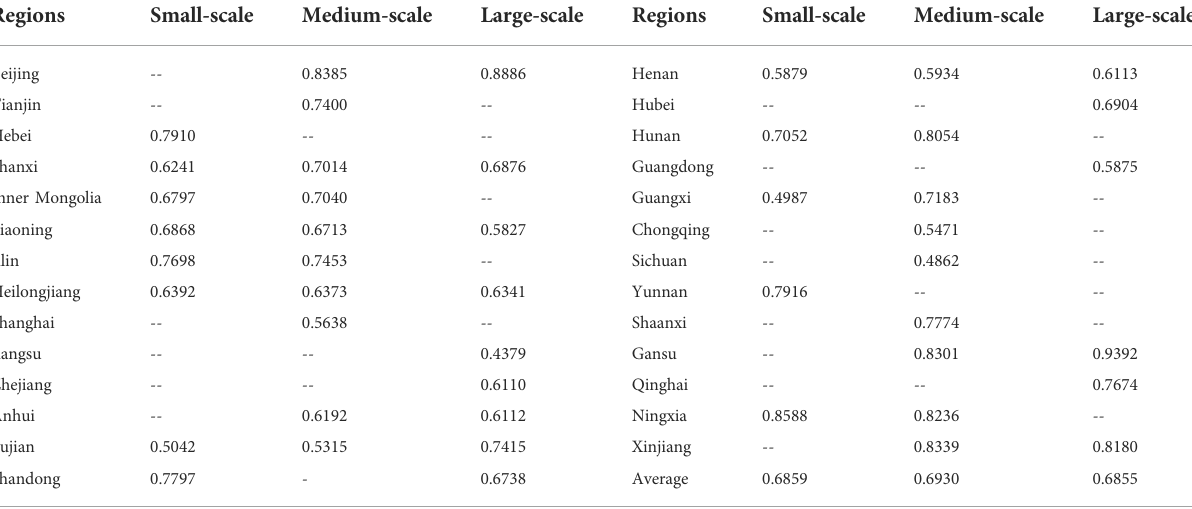
TABLE 2 Calculation results of environmental ef fi ciency of dairy farming in different scales among provinces in China from 2004 to 2019.